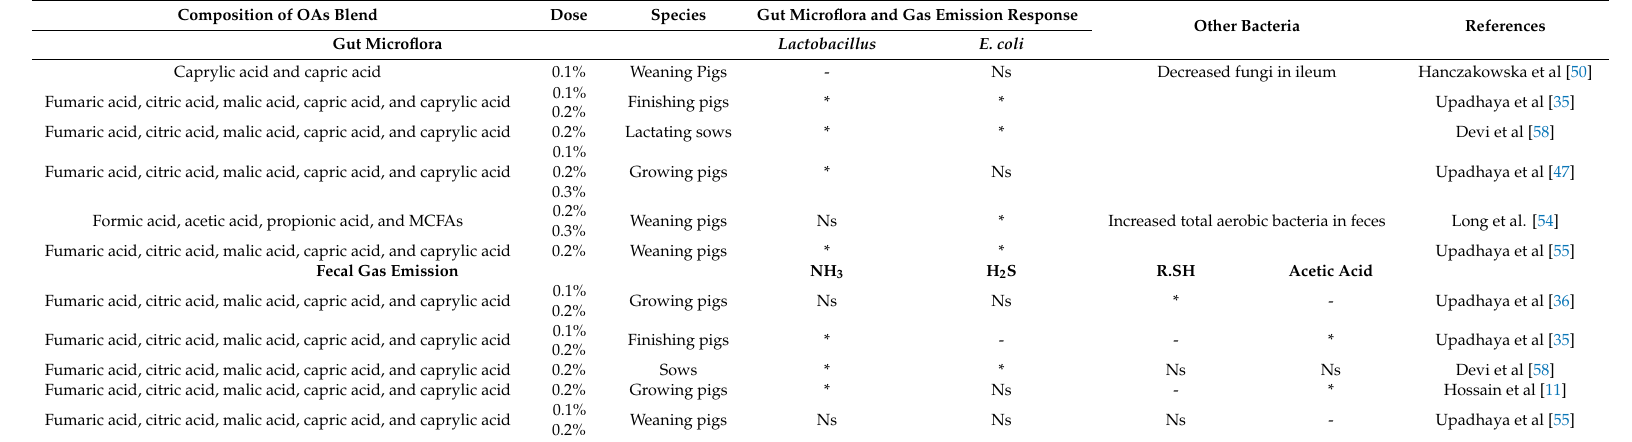
Table 4. E ff ects of OA mixtures on gut microflora and gas emission in